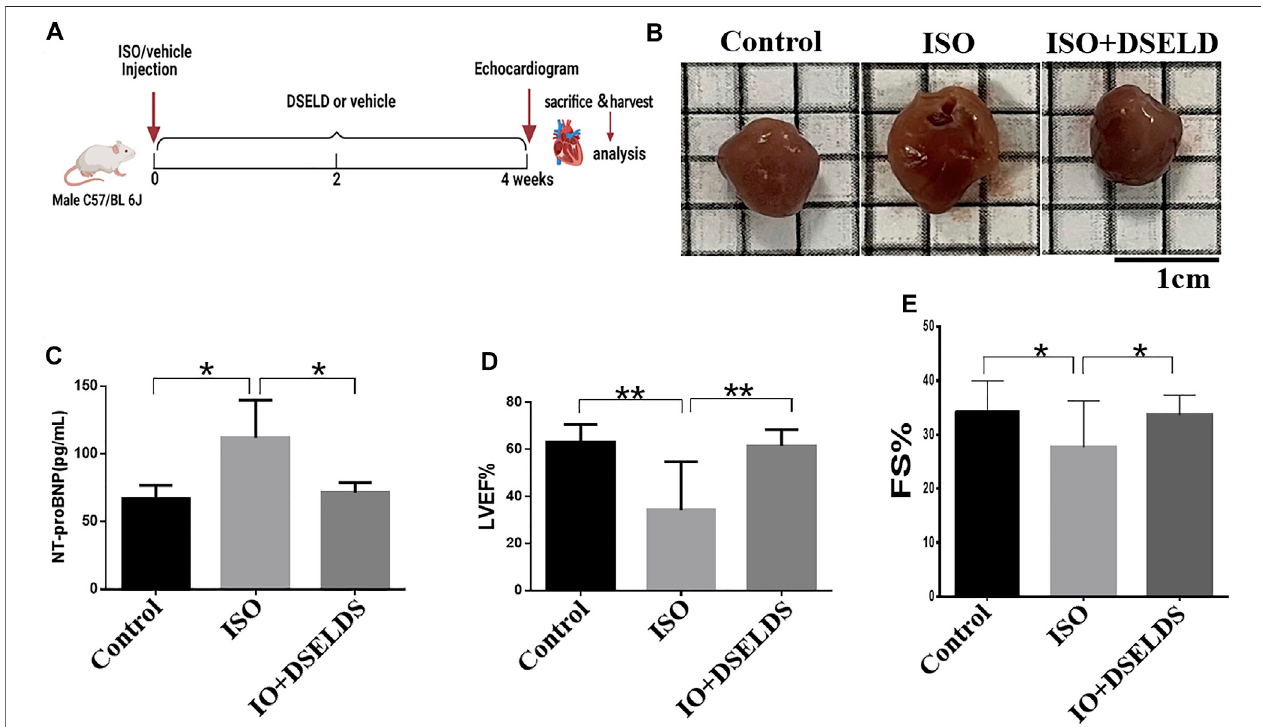
FIGURE 1 | Dangshen Erling decoction (DSELD) improves cardiac function. (A) Establishment of heart failure (HF) mouse model. (B) The representative images of the heart from the isoproterenol (ISO)-induced HF mice with or without DSELD (1.28 g/kg) treatment. ( C – E ) NT-proBNP, left ventricular ejection fraction (LVEF), and fractional shortening (FS) in the ISO-induced HF mice with or without DSELD (1.28 g/kg) treatment, n (cid:1) 9 – 10. *p < 0.05, **p < 0.01.